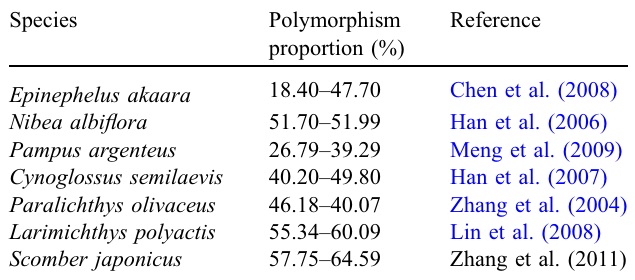
Table 3. Some known commercial fi shes ’ AFLP genetic diversity.